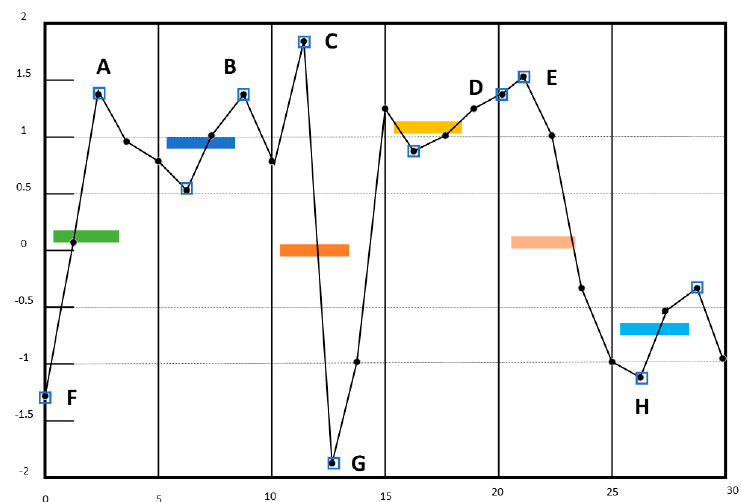
Figure 5. Time series represented as ‘adfeeffcaefffdaabc’ by ESAX [25]. Where the length of time series is 30, the number of segments is 6 and the size of symbols is 6. The capital letters A–H represent the maximum and minimum values in every segment.